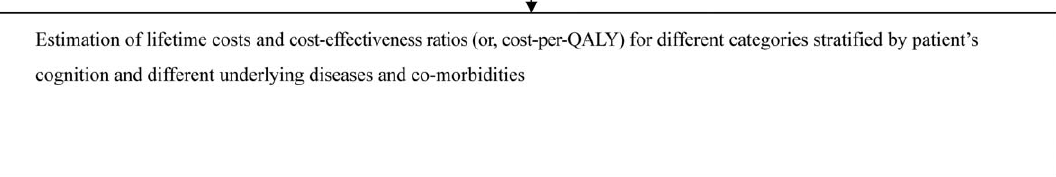
Figure 1. Flow chart of the computation process for lifetime costs and cost-per-QALY (quality-adjusted life year).